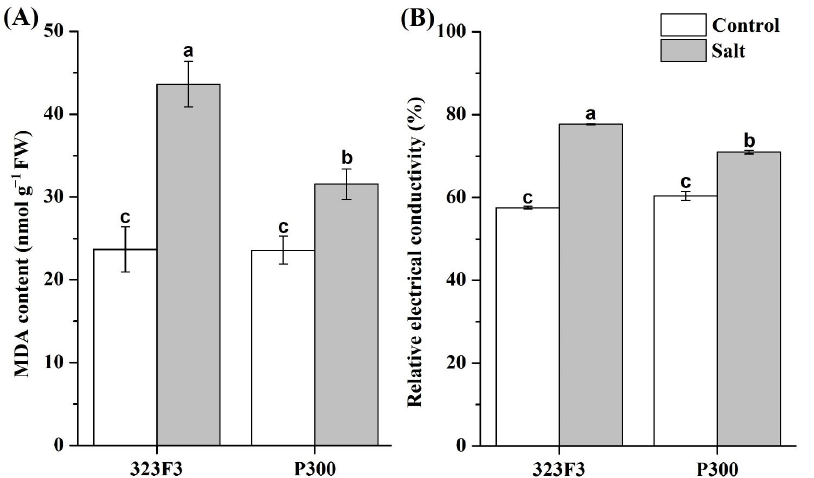
Figure 5. MDA content ( A ) and relative electrical conductivity ( B ) in the leaves of 323F3 and P300. Each bar represents three biological replicates ± SD. Different small letters represent significant differences at p < 0.05 according to one ‐ way ANOVA.